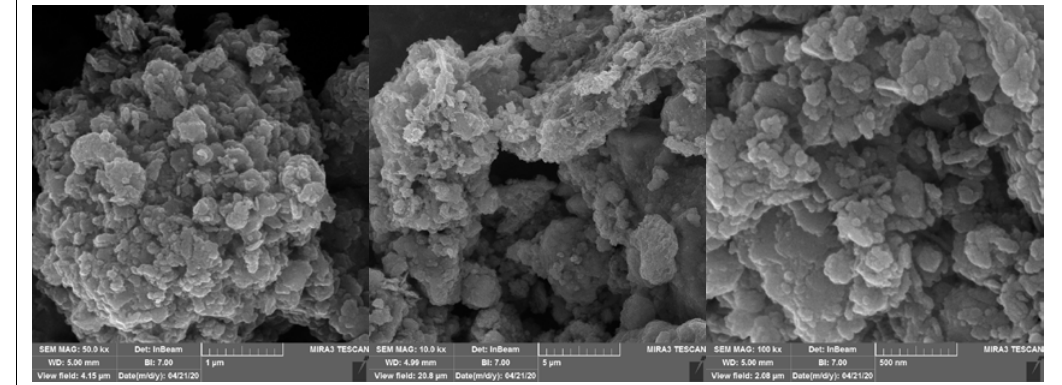
Fig. 2. FE-SEM images of Fe